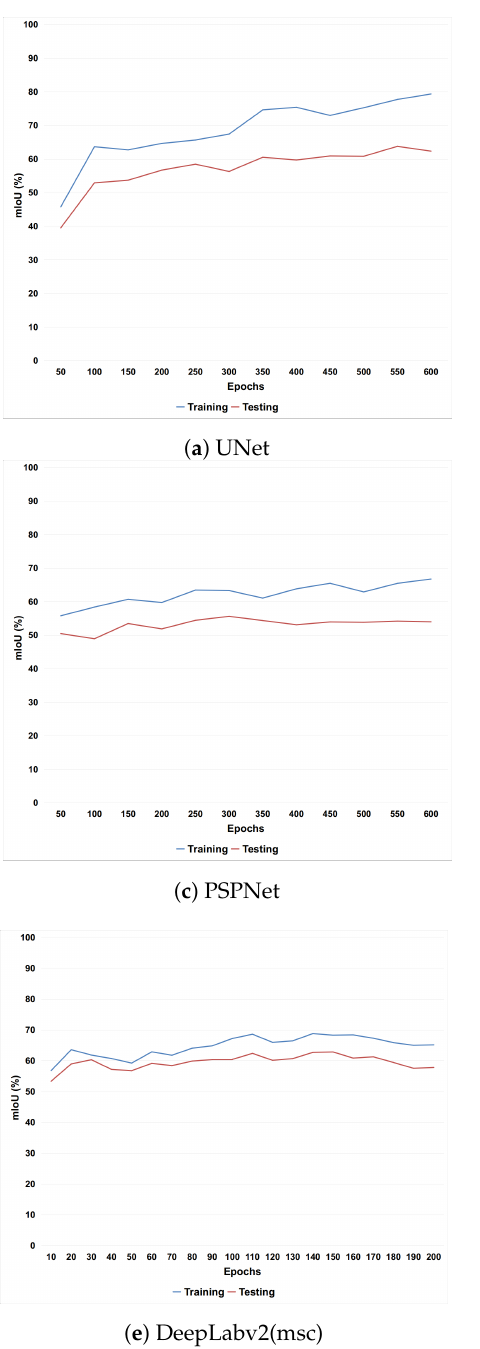
Figure 7. Accuracy in terms of mean-IoU measured in training and testing set for each model, over a range of